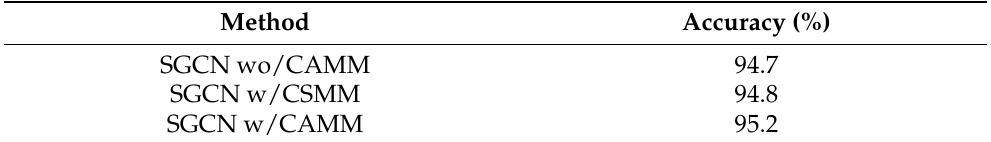
Table 1. Comparisons of validation accuracy when the model with or without CAMM. ‘w/’ means ‘with’, ‘wo/’ means ‘without’.